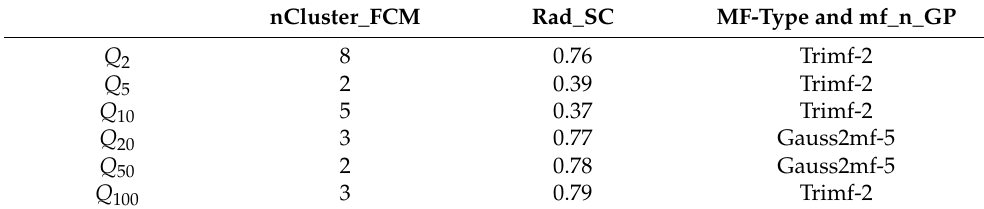
Table 2. Rad_SC, nCluster _FCM, mf-type, and mf_n for GP.